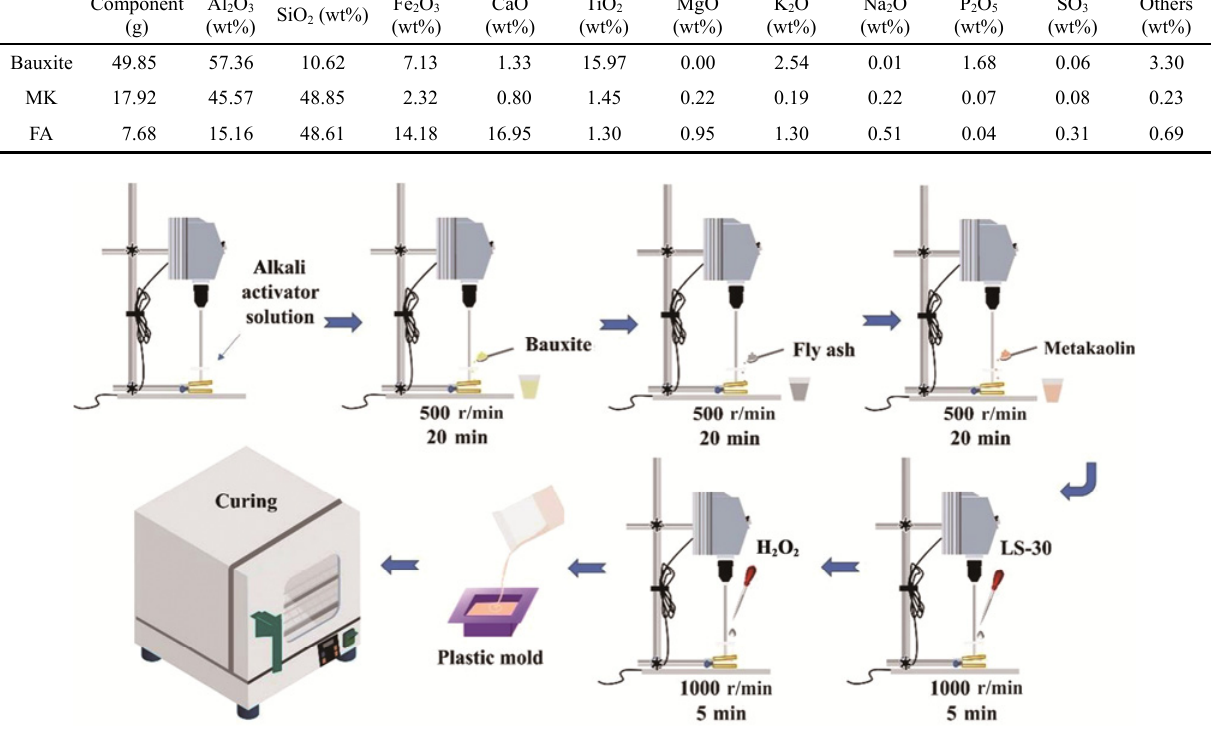
Fig. 1 Schematic illustration of the preparation procedure for porous geopolymer